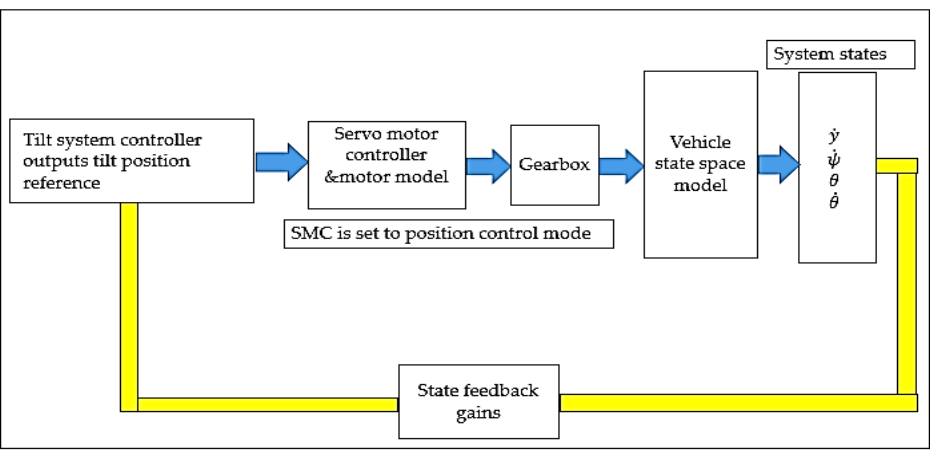
Figure 5. Control loop configuration of tilt control and servo motor control.